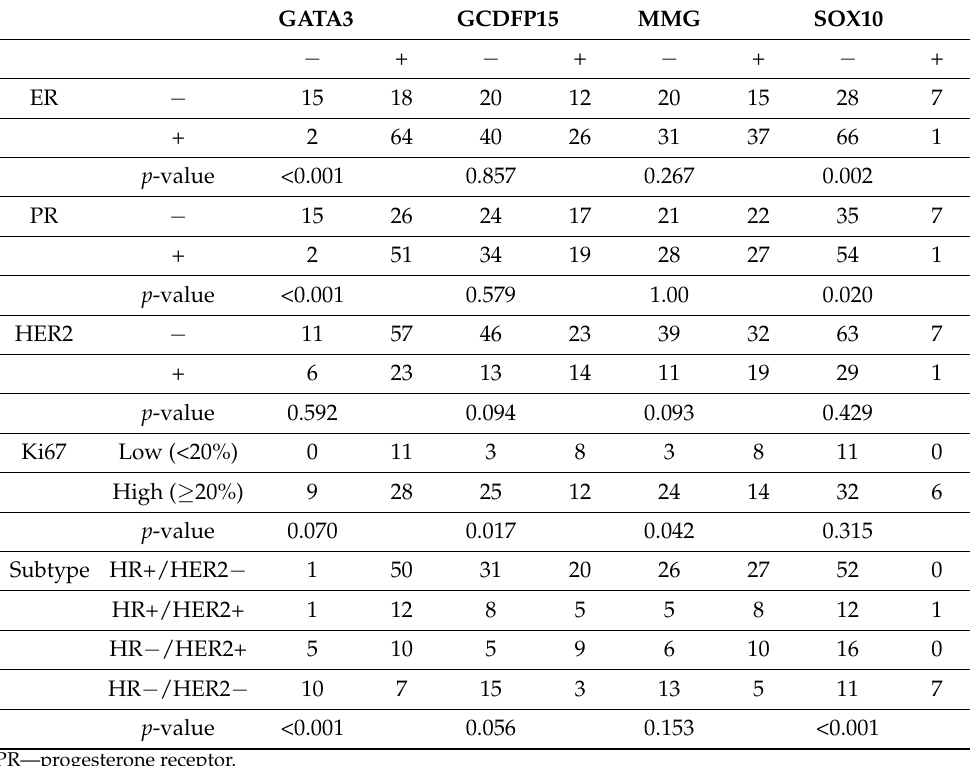
Table 5. Comparison of estrogen receptor (ER), GATA3, gross cystic disease fluid protein-15 (GCDFP15), mammaglobin (MMG) and SOX10 expression with biomarker status.